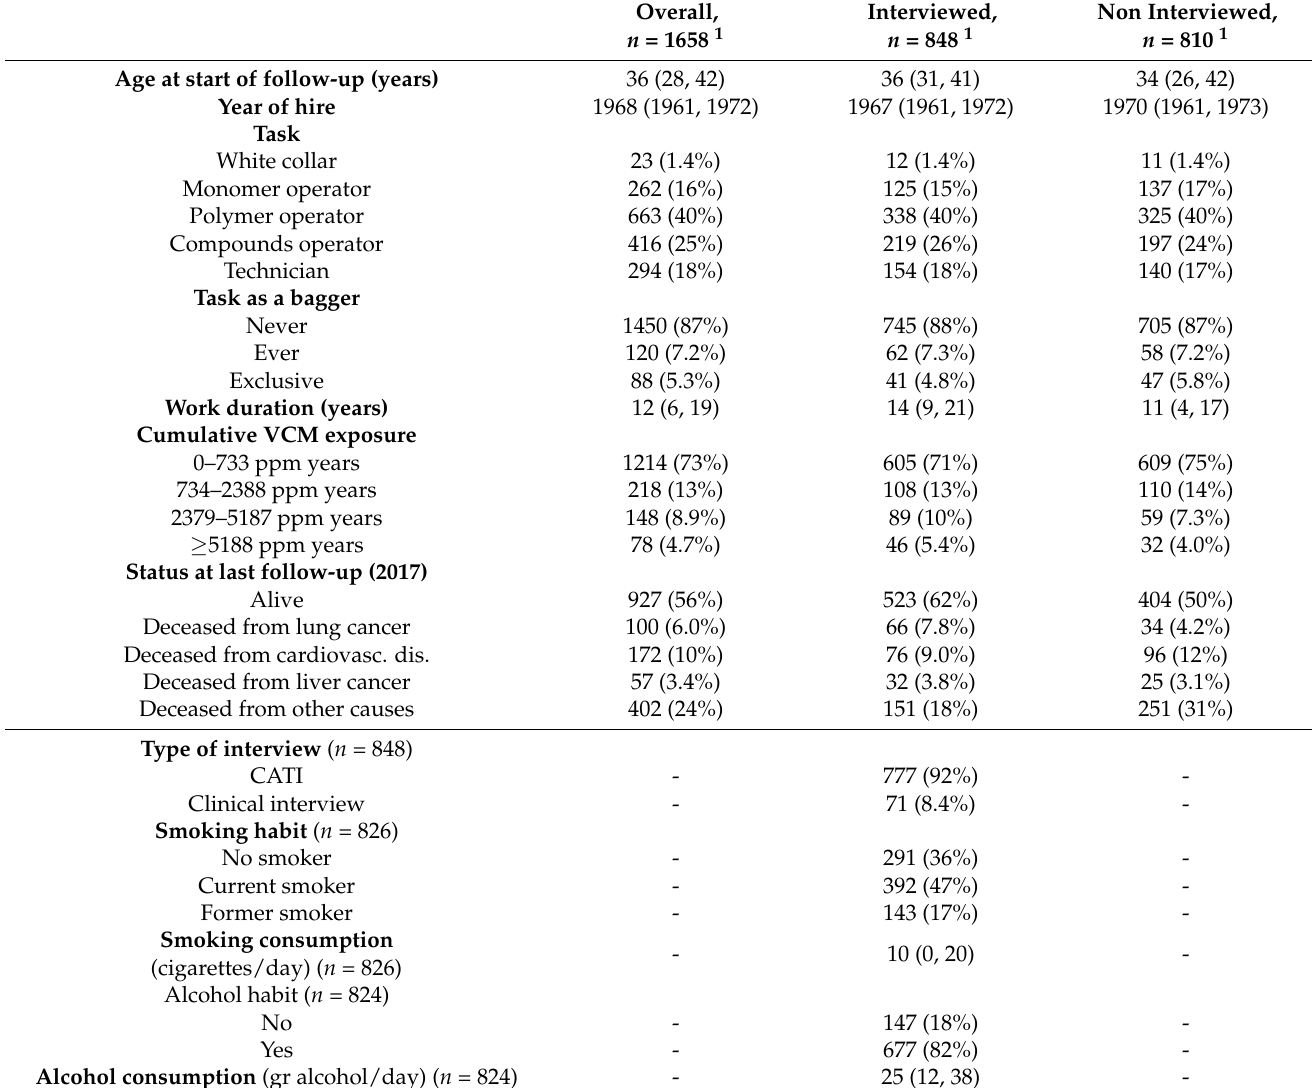
Table 1. Main characteristics of the cohort as a whole and from interviews.